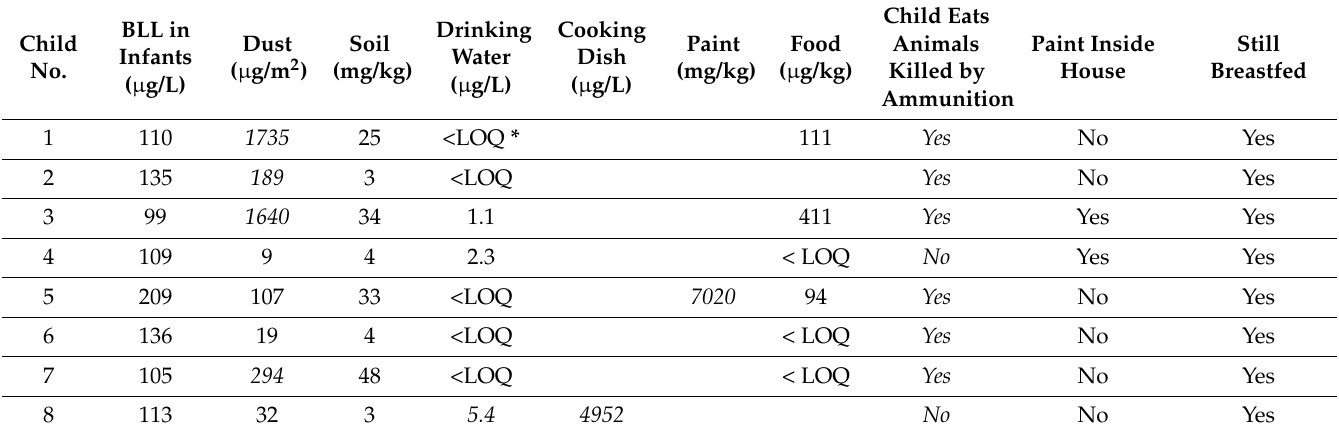
Table 4. Lead concentrations in potential sources for children with